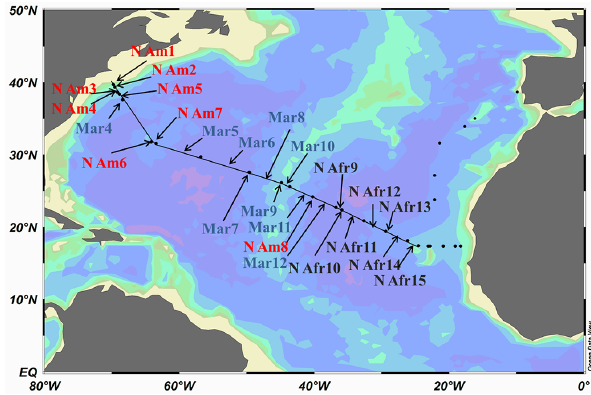
Figure 1. Aerosol particulate collection locations during the 2011 US GEOTRACES cruise. Arrows pointing to a dot were collected on station. Arrows pointing to the line were collected in transit. Samples labeled as “N Am”, and “N Afr” showed a majority of 5- day ensemble air mass back trajectories extending back to the North American and African continents. Samples labeled “Mar” showed 5 day ensemble air mass back trajectories that had minimal conti- nental